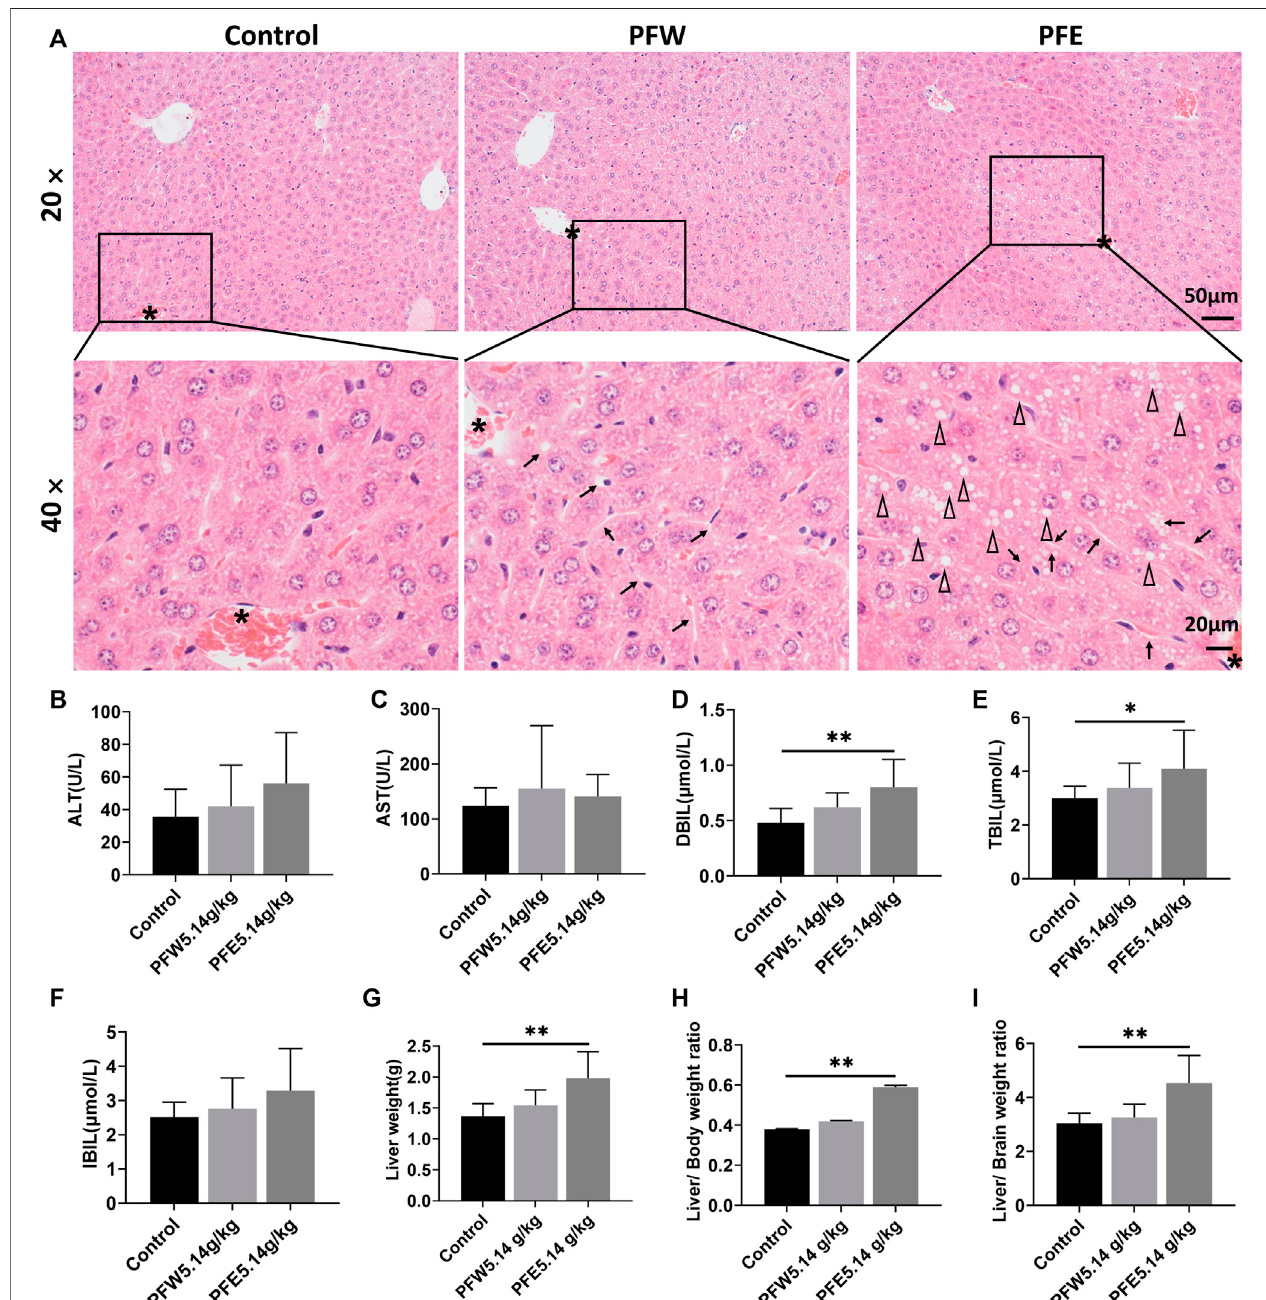
FIGURE1| PFW-andPFE-inducedliverinjury. (A) Representativehistopathologicalmicrophotographsofmouseliverillustratingthecontrol,PFW,andPFEgroups at × 20 (top line) and × 40 (bottom line) magni fi cation. The asterisk indicates the central vein. Arrows indicate hepatocyte hypertrophy. Triangle indicates vacuolation. (B) ALT. (C) AST. (D) DBIL. (E) TBIL. (F) IBIL. (G) Liverweight. (H) Liver/bodyweightratio. (I) Liver/brainweightratio.Valuesarerepresentedasmean ± SD, n (cid:1) 10.* p < 0.05 and ** p < 0.01 versus the control group.